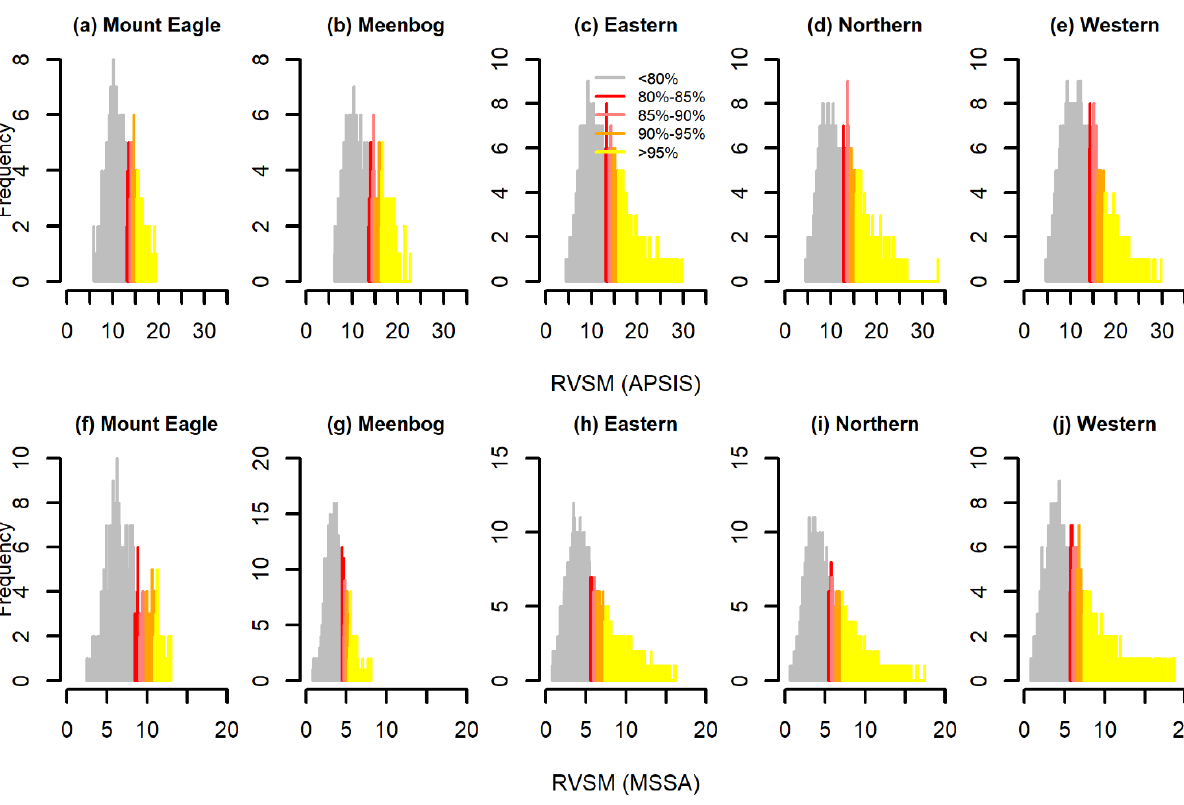
Figure 3. Frequency distributions of RVSM (mm) for 1–12 months for the Mount Eagle and Meenbog study sites and the regional upland areas, showing the percentile dynamic ranges selected to discriminate extreme values in Figure 4. The Shass Mountain study site is included in the Northern upland area. Note that the classification for Shass Mountain was based on the distribution for the whole of the Northern